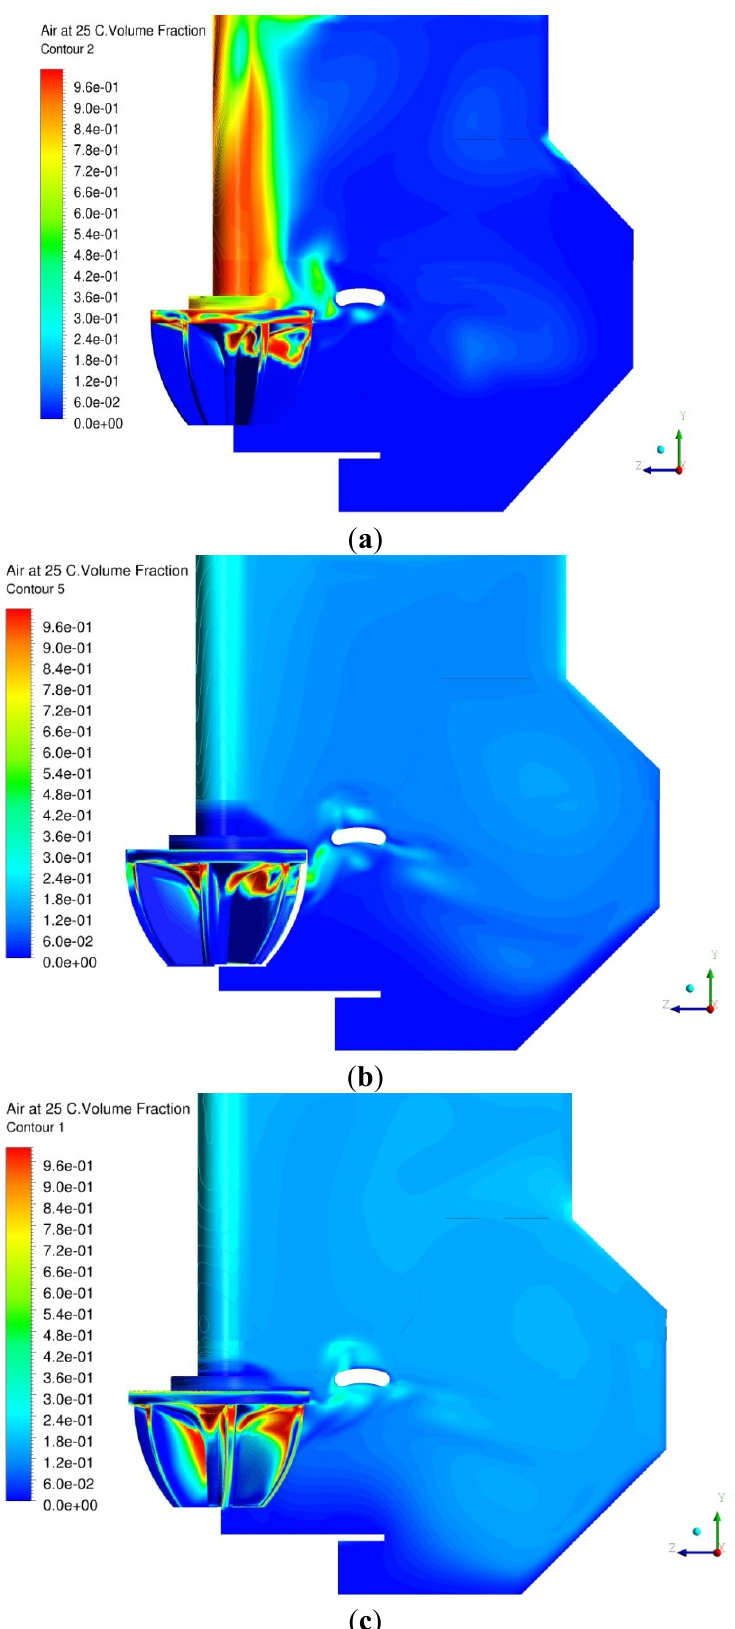
Figure 6. ( a ) Air volume fraction (α) contours for bubble diameter = 2 mm; ( b ) Air volume fraction (α) contours for bubble diameter = 1 mm; and ( c ) Air volume fraction (α) contours for bubble diameter = 0.5